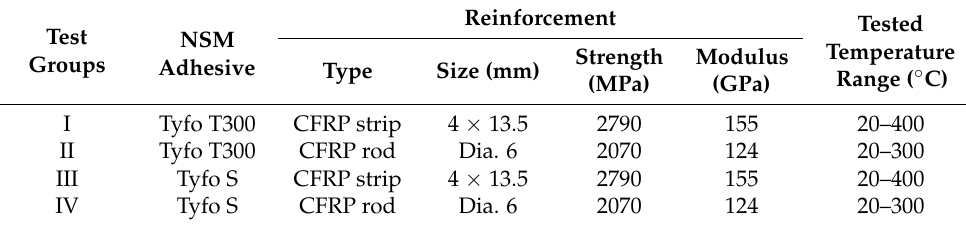
Table 6. Properties of NSM FRP specimens used in the bond test